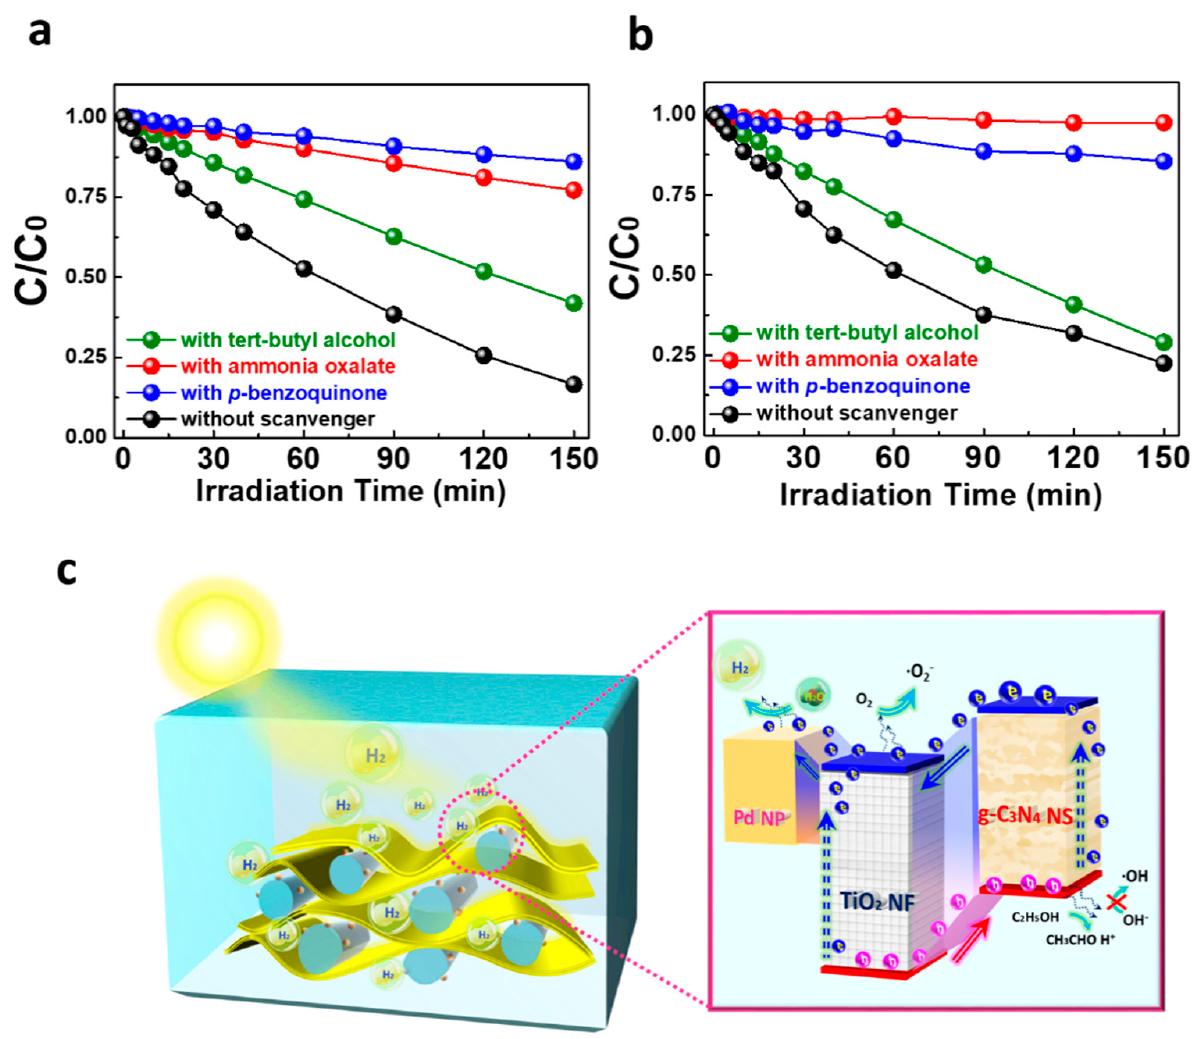
Figure 8. The photodegradation curves of ( a ) TiO 2 NF and ( b ) 5.0 wt% g-C 3 N 4 /TiO 2 catalyst toward the methyl orange with various scavengers, and ( c ) the scheme of the charge transfer mechanism.